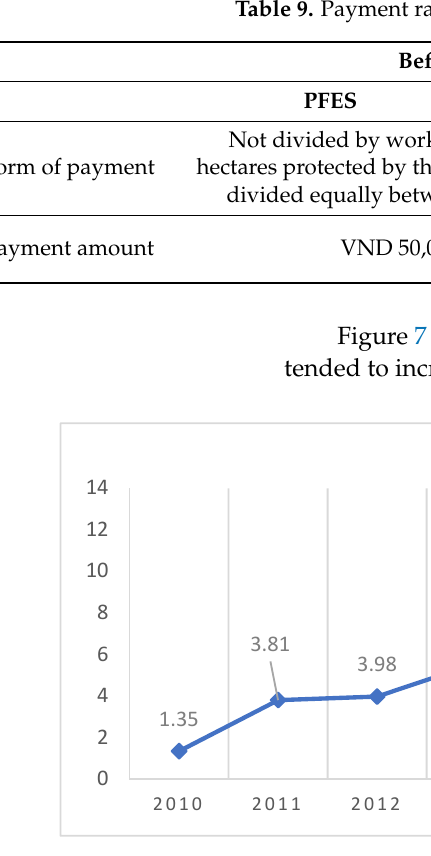
Figure 7. Annual income from PFES by year (VND × million). Source: compiled by the research team. PFES unit prices from 2010 to 2019 in Dong Nai, Lam Dong and Binh Phuoc provinces